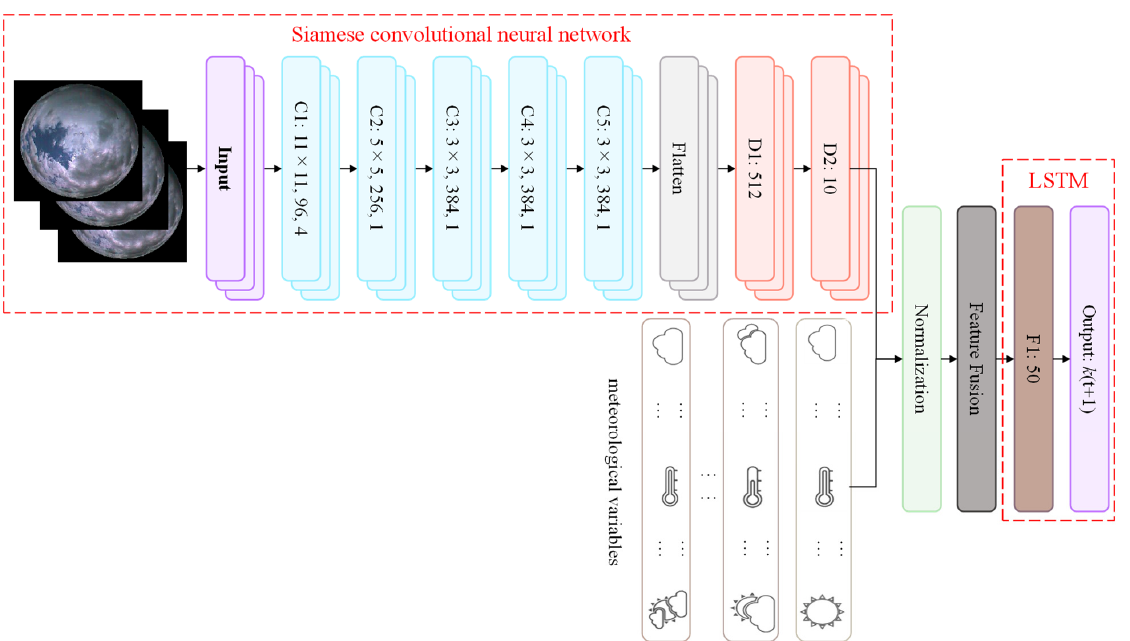
Figure 3. The structure of the Siamese convolutional neural network–long short-term memory (CNN–LSTM) model for predicting the direct normal irradiance (DNI) 10 min in advance, where C means convolution layer, D means dense layer, and F means fully connected layer.